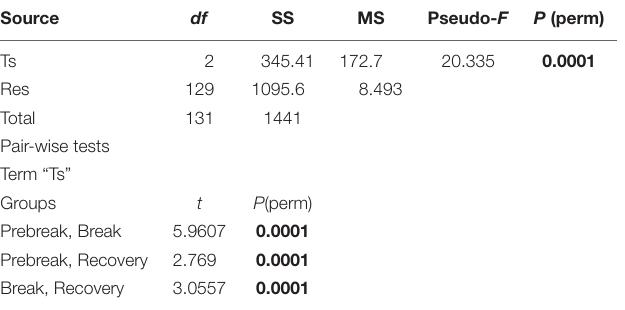
TABLE 5 | Results of PERMANOVA analyses for the meteorological and hydrographic conditions considering the factors Trophic status phase (Ts).